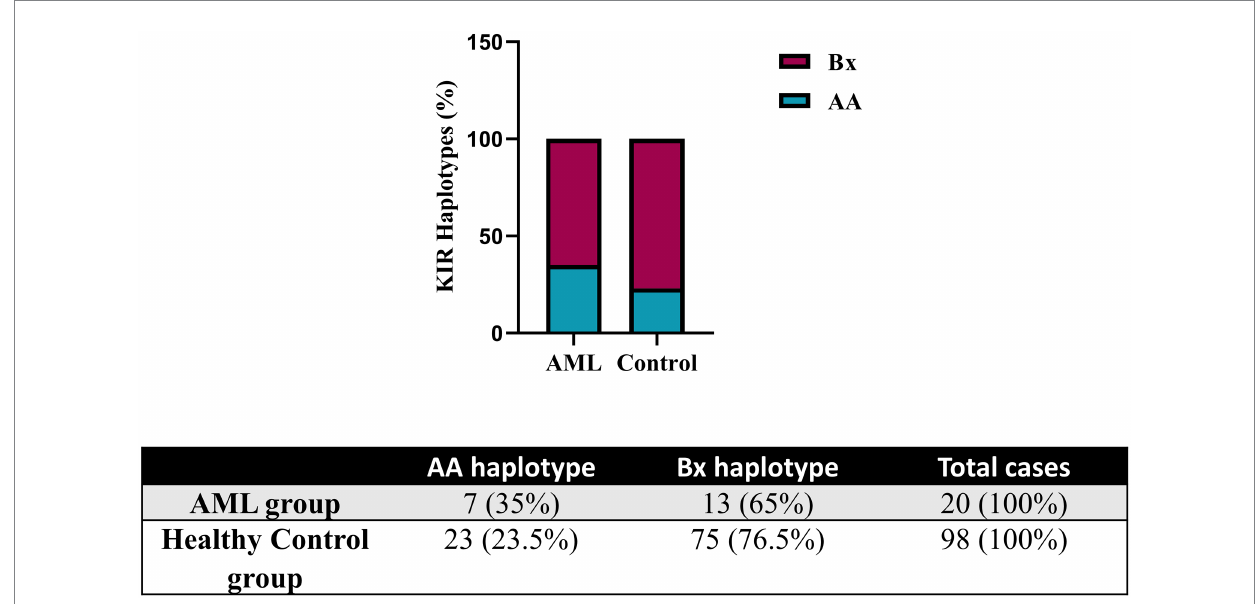
FIGURE 6 Frequency of KIR haplotypes in AML and healthy control individuals. Bars represent the percentages of AA (blue) and Bx (red) haplotypes of KIR genes ( n = 20 for AML, n = 98 for the healthy control group).